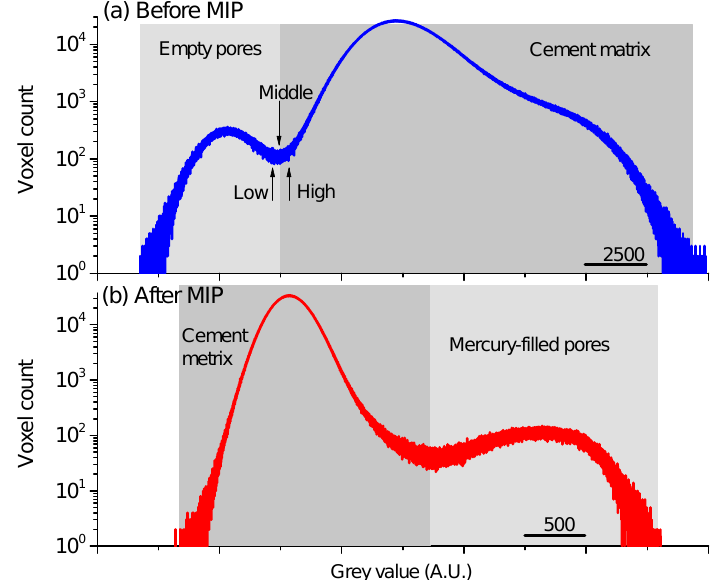
Figure 5. Voxel-grey value distributions of a VOI in the paste sample ( a ) before and ( b ) after mercury intrusion. Three threshold values (low, middle and high) were selected to test the influence of threshold process on pore segmentation.